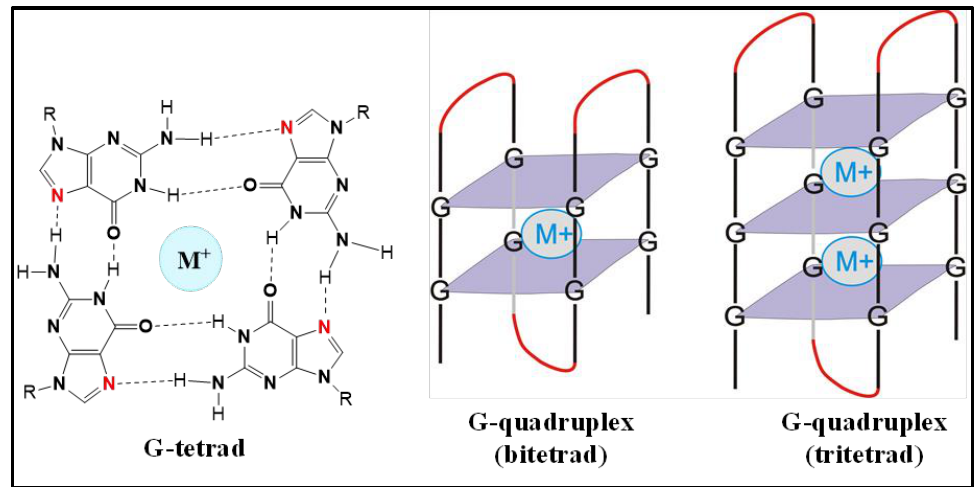
Figure 1. The chemical structure of a guanine tetrad featuring a central metal cation (G-tetrad), two- tier (bi-tetrad) and three-tier (tri-tetrad) G-quadruplexes.